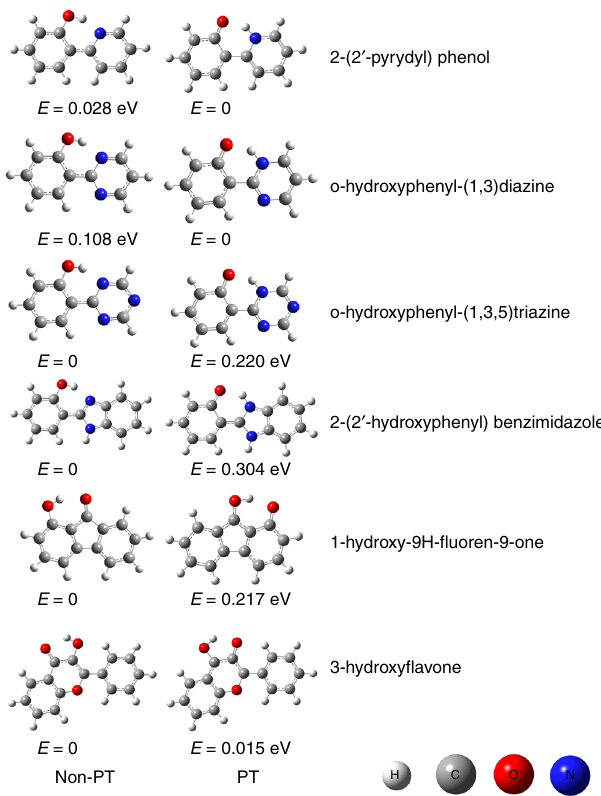
Fig. 4 Molecular anion structures and relative energies. Structures and relative energies of the PT and Non-PT forms of several molecular